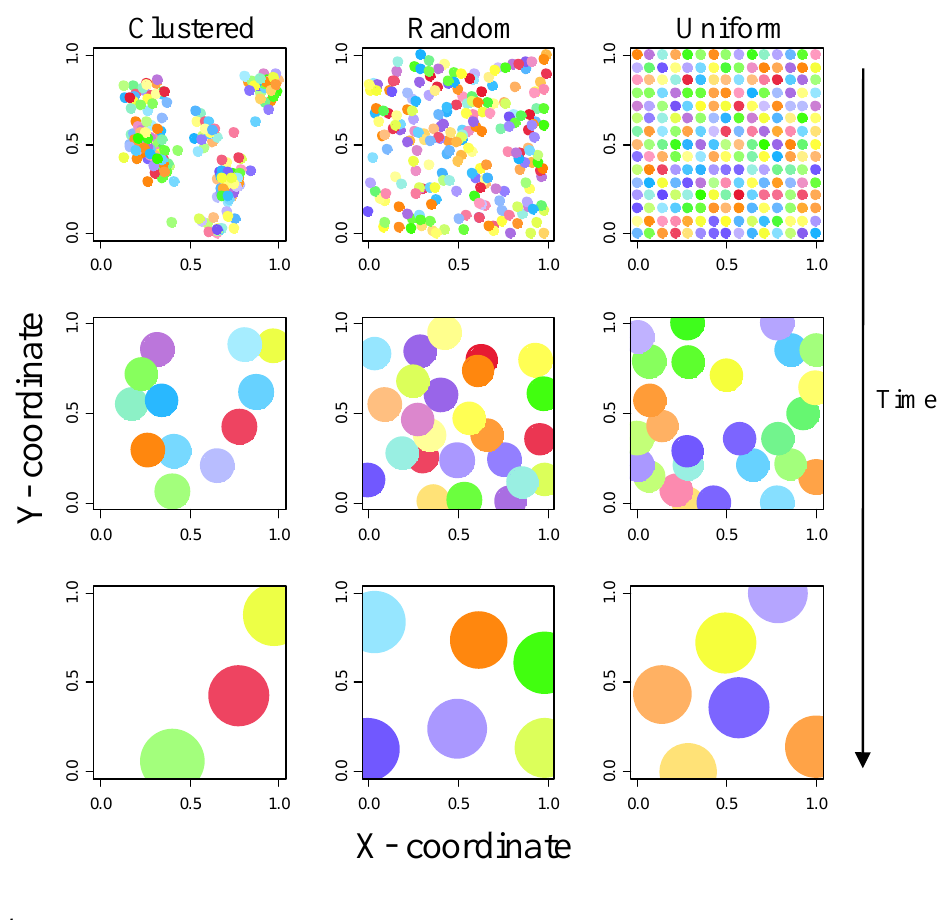
Figure 1. A top-down view of simulated communities at three points in time: 1, 15, and 30. Each column of the panel depicts the results for a different initial spatial distribution: clustered, random, or uniform. Each circle represents an individual, the color of the circle indicates the species identity, and the area of the circle is equal to the area that the individual occupied in the 1 × 1 window. The same number of individuals was in each community